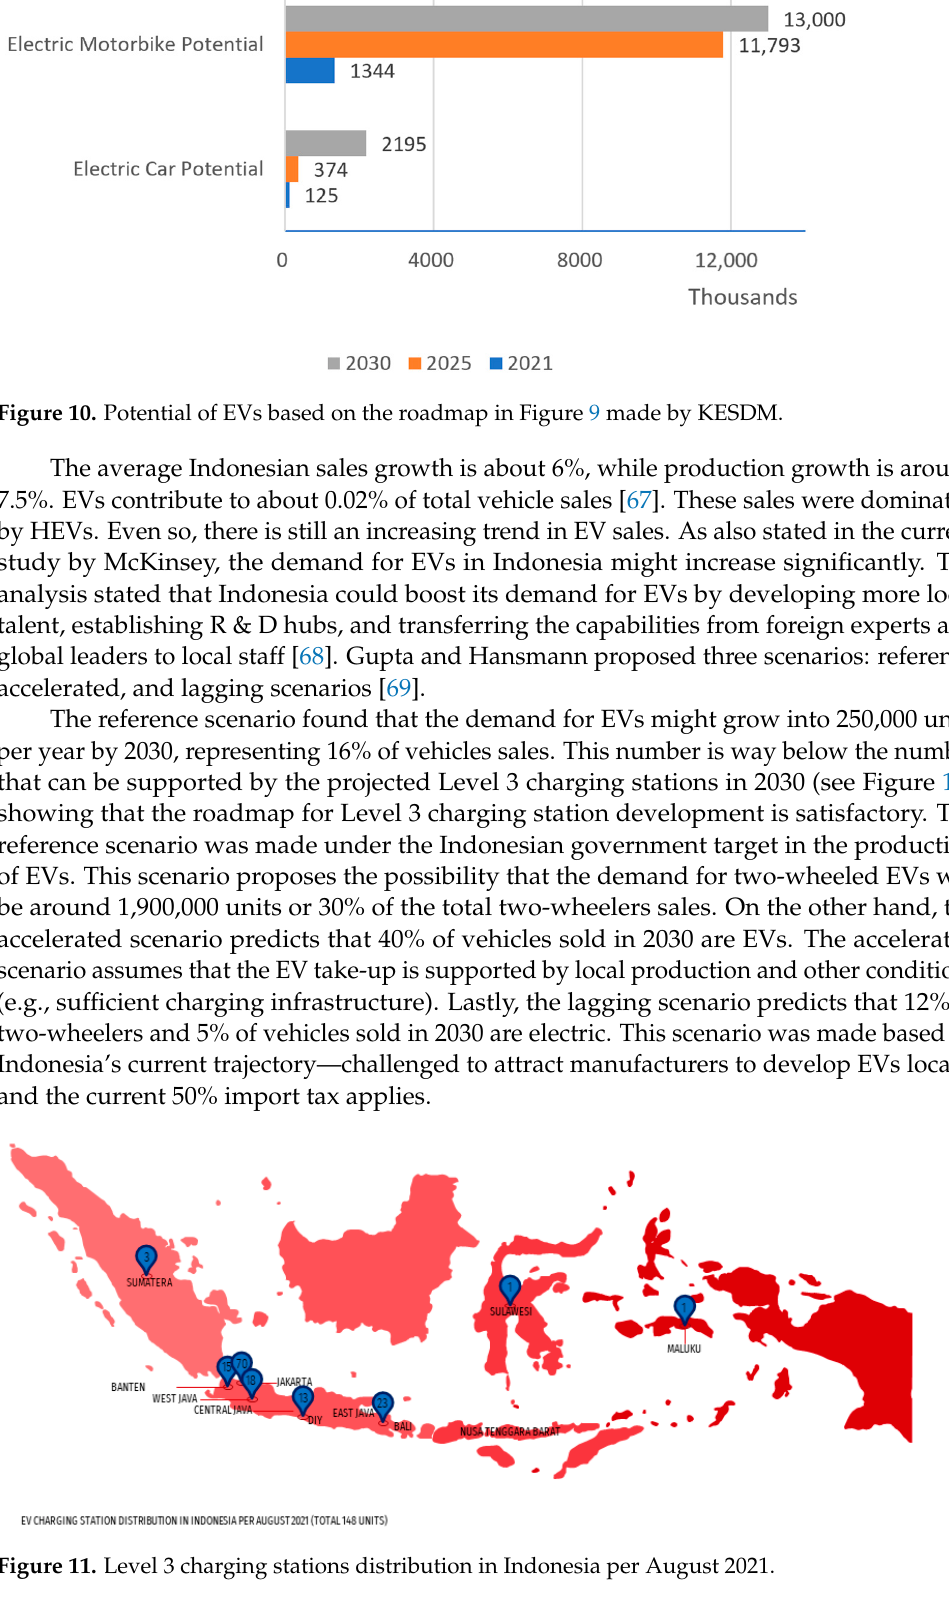
Figure 9. Roadmap of battery replacement and Level 3 charging stations made by KESDM.